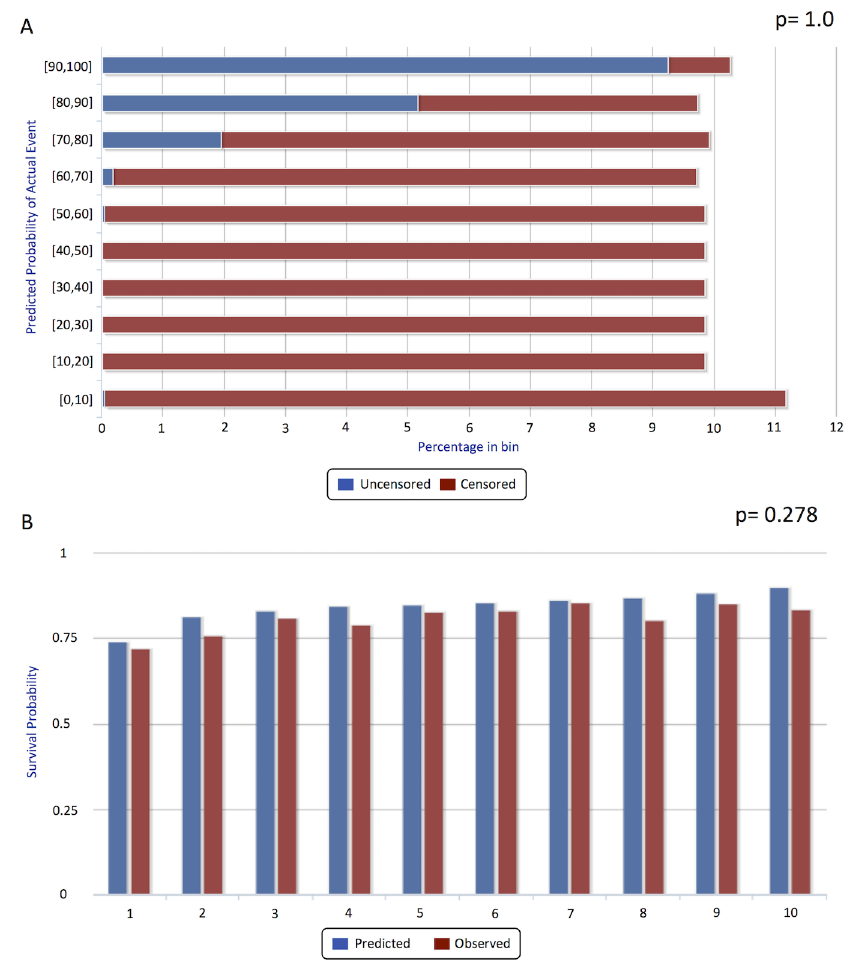
Fig 4. Distribution-calibration and single-point calibration (1-calibration). Panel A shows the observed distribution of events (death) histogram for each predicted decile of the survival distribution. The “p-value” here (1.0) is the result of the χ 2 test. Panel B shows the 5-years post post-transplant goodness-to-fit calibration (a.k.a. 1-calibration) histogram. Blue bars correspond to predicted and red bars to observed events, for each deciles of risk category according to the model. The p-value is 0.278, suggesting good calibration